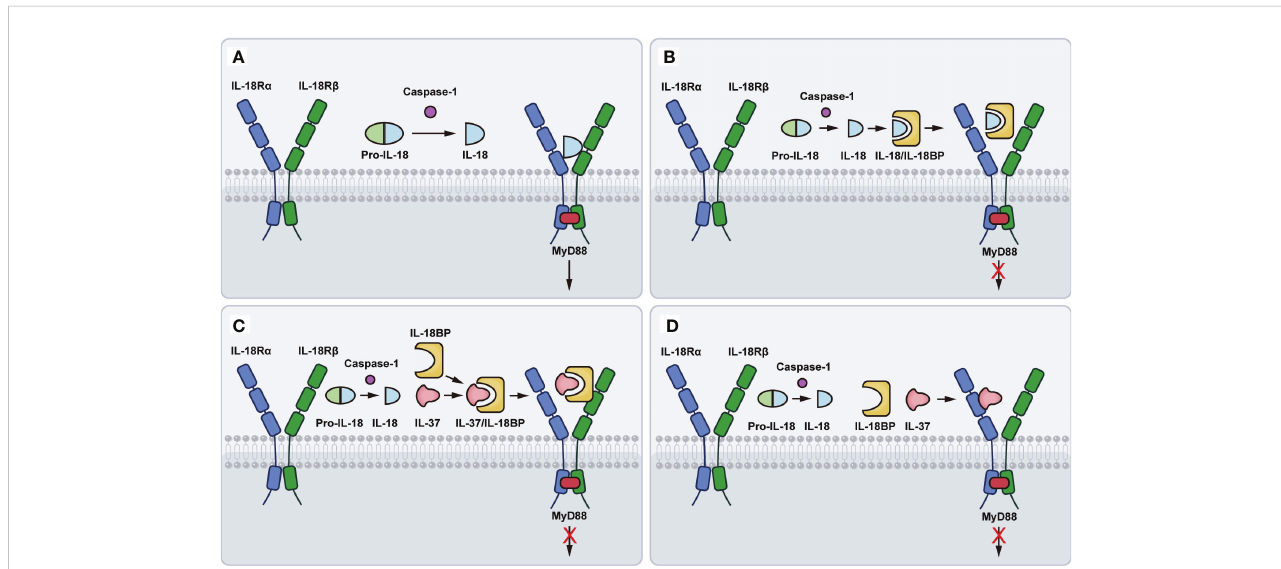
FIGURE 1 Schematic representation of IL-18 binding to IL-18R. (A) The pro-IL-18 is processed by the caspase-1 to produce mature and active IL-18. Mature IL-18 links to the low-af fi nity IL-18R a to form an inactivated IL-18/IL-18R a binary complex, which recruits the IL-18R b chain to develop a high-af fi nity complex that launches IL-18-dependent signaling pathway. (B) IL-18BP binds to IL-18 and further forms a blunting complex with IL-18R a , preventing IL- 18R b from activating cells. (C) IL-37 binding to IL-18BP, forms a complex with IL-18R b , thereby enhancing the inhibition of IL-18 activity. (D) IL-37 binds to IL-18R a , causing the loss of recruitment with IL-18R b